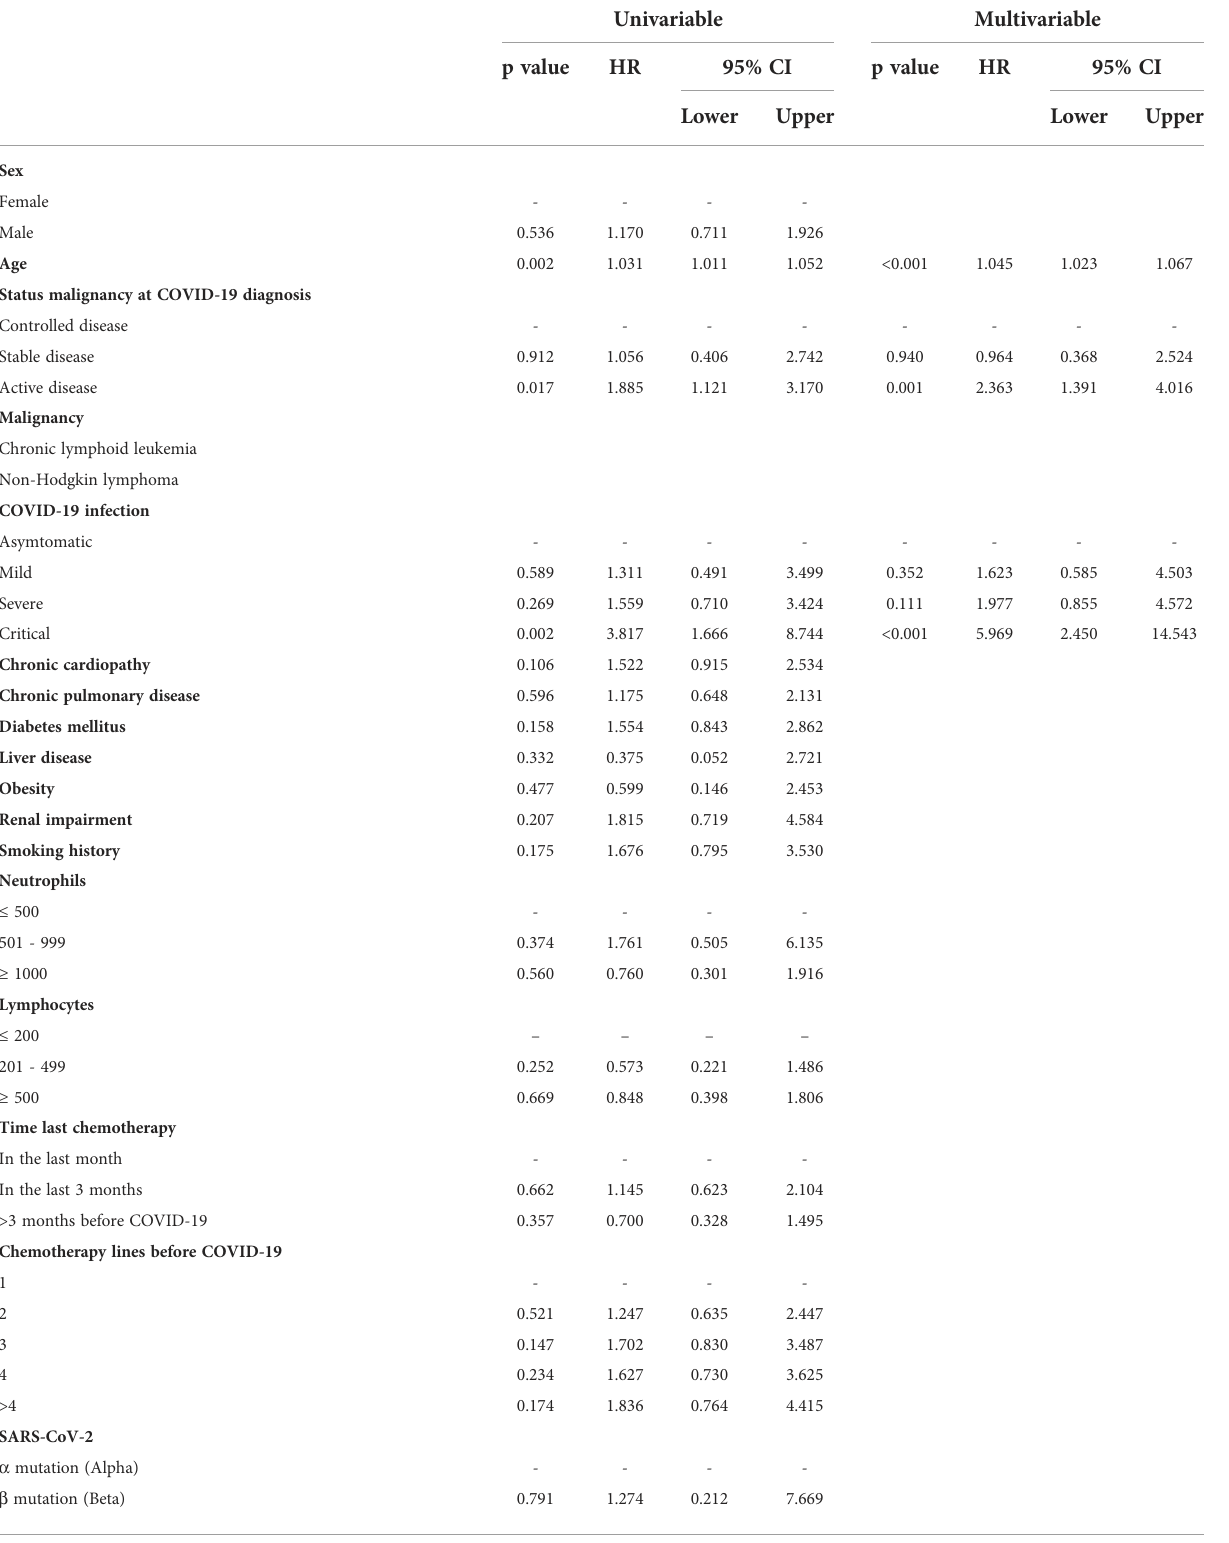
TABLE 4C Univariable and multivariable analysis of predictors of mortality in the NHL